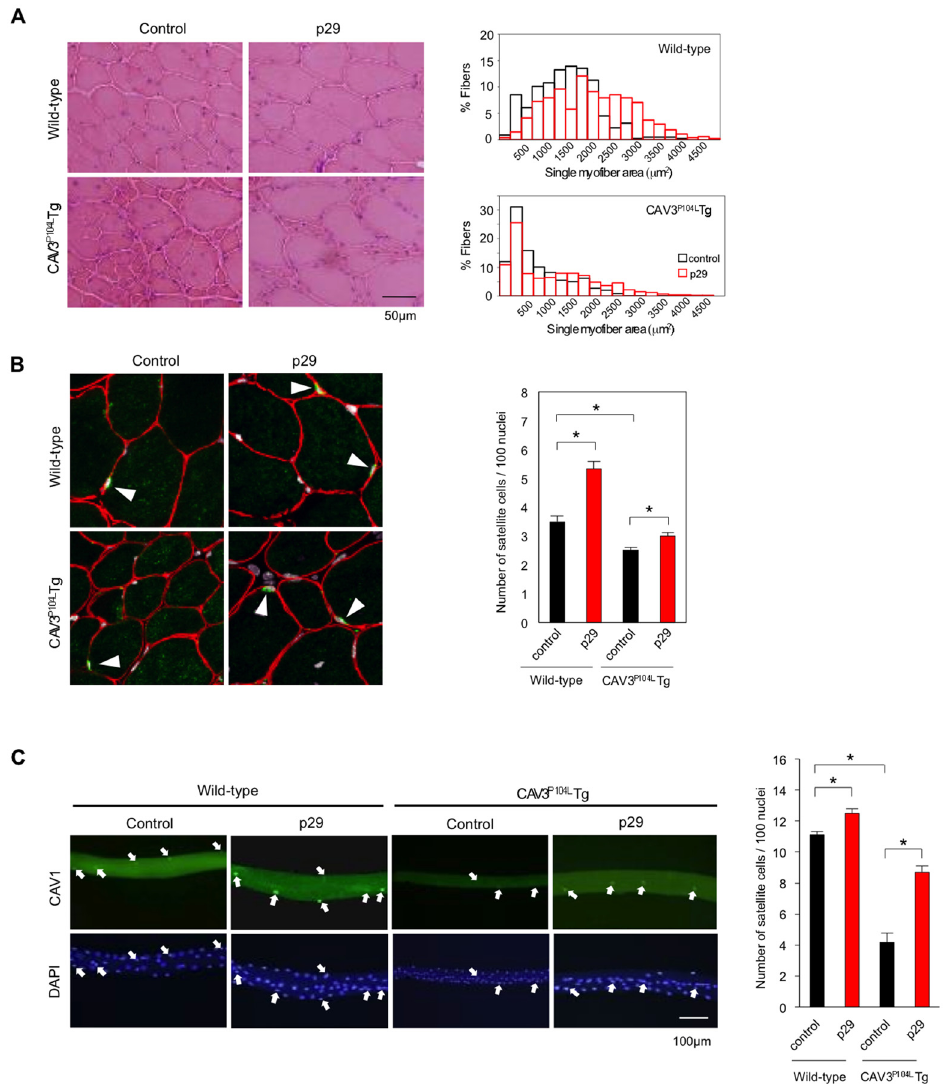
Fig 8. Local injection of p29 alleviates the reduction in myofiber size by restoration of the decreased numbers of satellite cells. ( A ) Histological analysis of TA muscles treated with p29 or albumin (control) in wild-type ( upper ) and CAV3 P104L ( lower ) mice. Scale bar, 50 μ m ( left ). Distribution of SMAs in TA muscles of mice treated with p29 or albumin ( right ; n = 7; 250 myofibers were assessed in each mouse). ( B ) Immunohistochemical analysis of M-cadherin-positive satellite cells (green, arrows) in TA muscles of wild- type ( upper ) and CAV3 P104L ( lower ) mice ( left) treated with p29 or albumin. Red indicates laminin α 2 and gray indicates nuclei. Numbers of satellite cells per 100 myonuclei in TA muscles ( right ). One-thousand myonuclei were assessed in each muscle ( n = 7). * P < 0.05. ( C ) Fluorescence images of satellite cells attached to single myofibers isolated from the TA muscles of wild-type (Wild) and CAV3 P104L mice treated with (+) or without ( – ) p29 ( left ). Mouse caveolin 1 (CAV1) was used as a marker of satellite cells (green). Nuclei were counterstained with DAPI (blue). The white arrow indicates (satellite cells). Quantification of the number of satellite cells attached to single myofibers ( right ). Numbers of satellite cells per 100 myonuclei (right). Data are expressed as the mean ± SD ( n = 5). * P < 0.05.